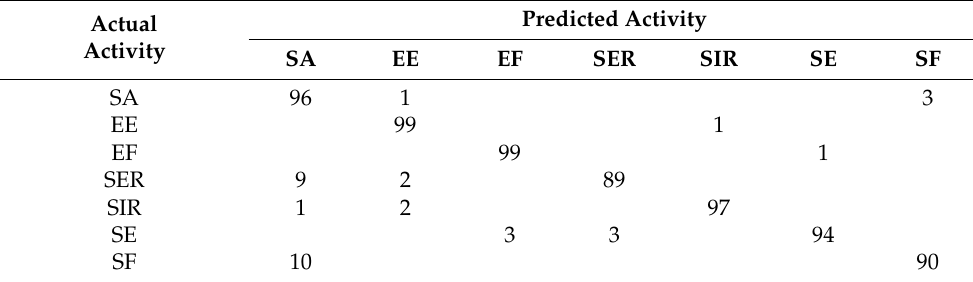
Figure 8. F1 score for each activity using different classification algorithms. Table 3. Confusion matrix for SVM classifier (in %). Cells with value 0 are left blank.